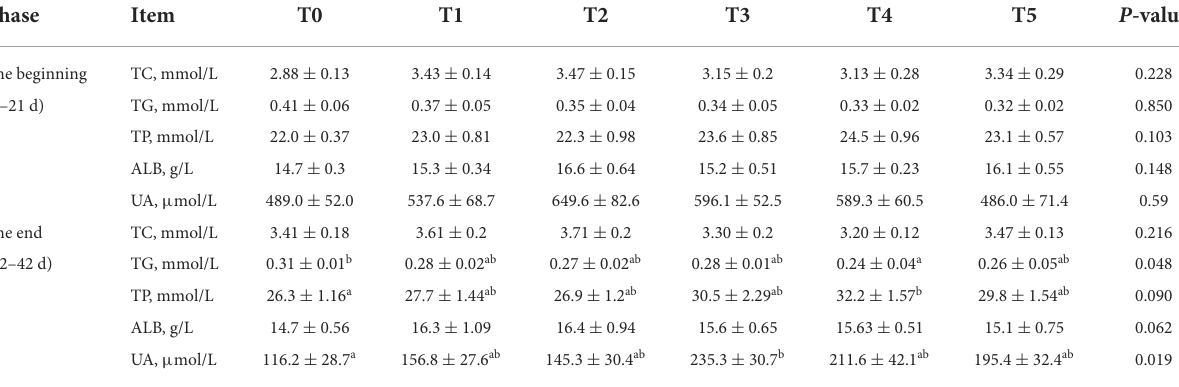
TABLE 4 Effects of adding CAP difference level on serum metabolism parameters of white-feather broilers (means ± SEM).